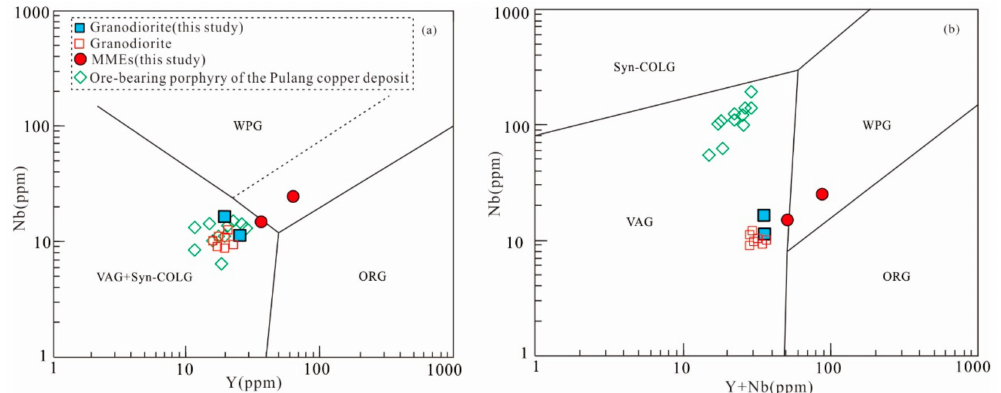
Figure 10. Discrimination diagrams for the tectonic setting of granodiorite and MMEs. (after [60]), Abbreviations: ORG, ocean ridge granite; WPG, within-plate granite; VAG, volcanic arc granite; Syn-COLG, syncollisional granite. Note: The data for granodiorite from [17,18]; the data for ore-bearing porphyry of the Pulang copper deposit from [10]. ( a ) Nb vs. Y diagram and ( b ) Nb vs. (Y + Nb)